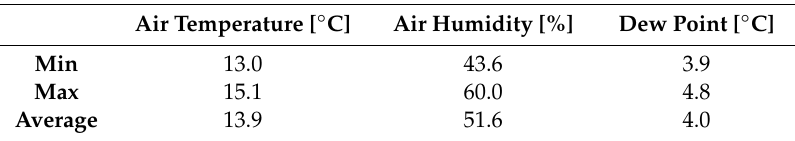
Table 5. Indoor microclimate before the application of insulation. Measurement taken from 27 January 2018 to 01 February 2018.